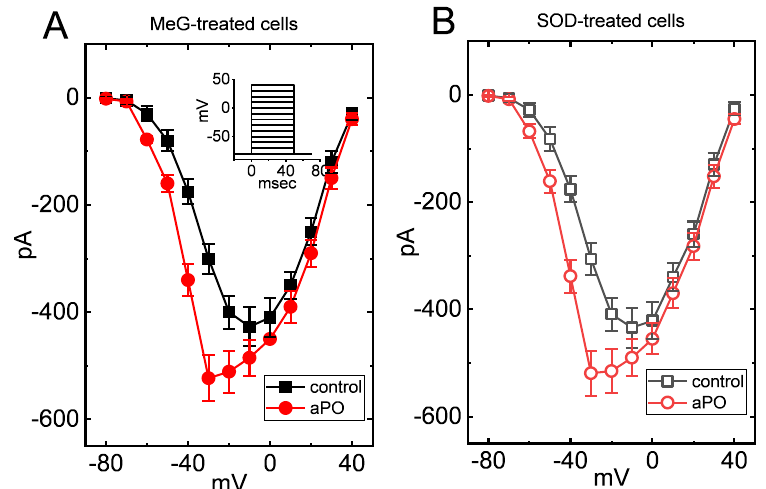
Figure 5. Stimulatory effect of aPO on averaged I-V relationship of I Na in GH 3 cells treated with methylglyoxal (MeG) ( A ) or with superoxide dismutase (SOD) ( B ). GH 3 cells were preincubated with 10 μM MeG for 6 h. Cells were bathed in Ca 2+ -free Tyrode’s solution and the pipette was filled up with Cs + -containing solution. The cell tested was maintained at −80 mV and the depolarizing pulses ranging between −80 and +40 mV were thereafter delivered to it. Each point represents the mean ± SEM (n = 7). Inset denotes the voltage-clamp protocol used. ■ or □: control; ●or ○ : aPO (10 μM). Noticeably, in MeG- or SOD-treated cells, the stimulatory effect of aPO on the overall I-V rela- tionships of peak I Na was altered little. The statistical analyses were undertaken by ANOVA-2 for repeated measures, p ( factor 1, groups among data taken at different levels of voltages) < 0.05, p (factor 2, groups between the absence and presence of aPO ) < 0.05, p (interaction) < 0.05, followed by post-hoc Fisher’s least-significant difference test, p < 0.05).